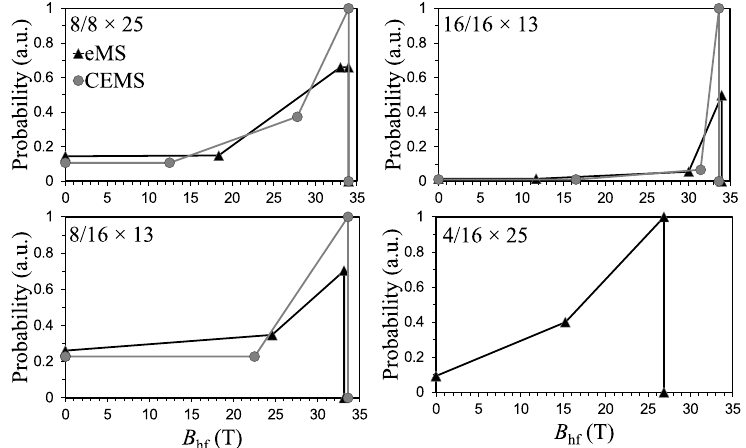
Figure 5. The normalized magnetic hyperfine field distributions (MHFD) from the analyses of eMS (triangles) and CEMS (circles) spectra. Table 1. The extracted room temperature (RT) fitting parameters of the spectra in Figures 3 and